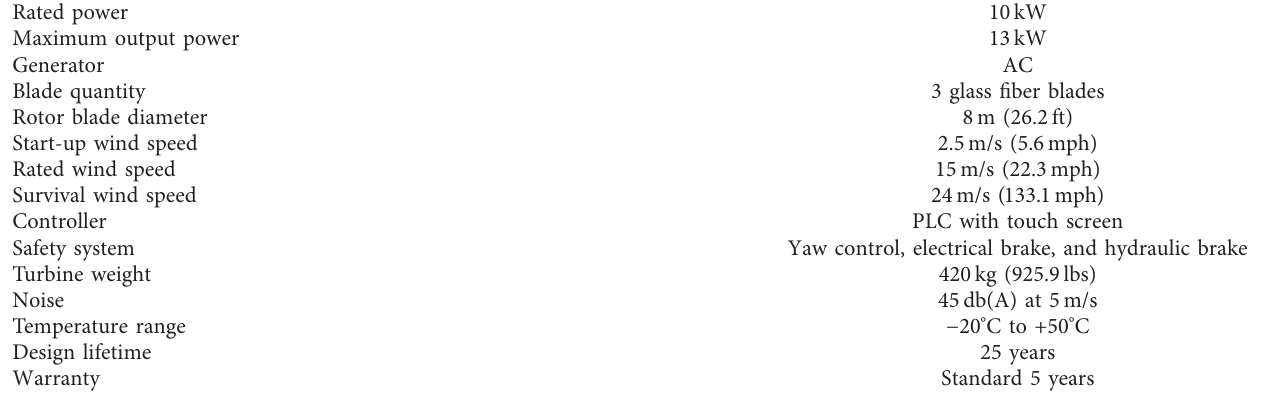
Table 1: Wind turbine specifications.